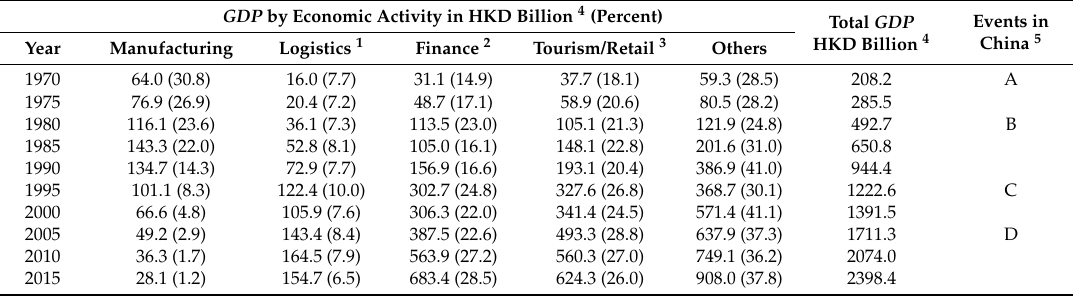
Table 2. Production-based gross domestic product ( GDP ) by economic